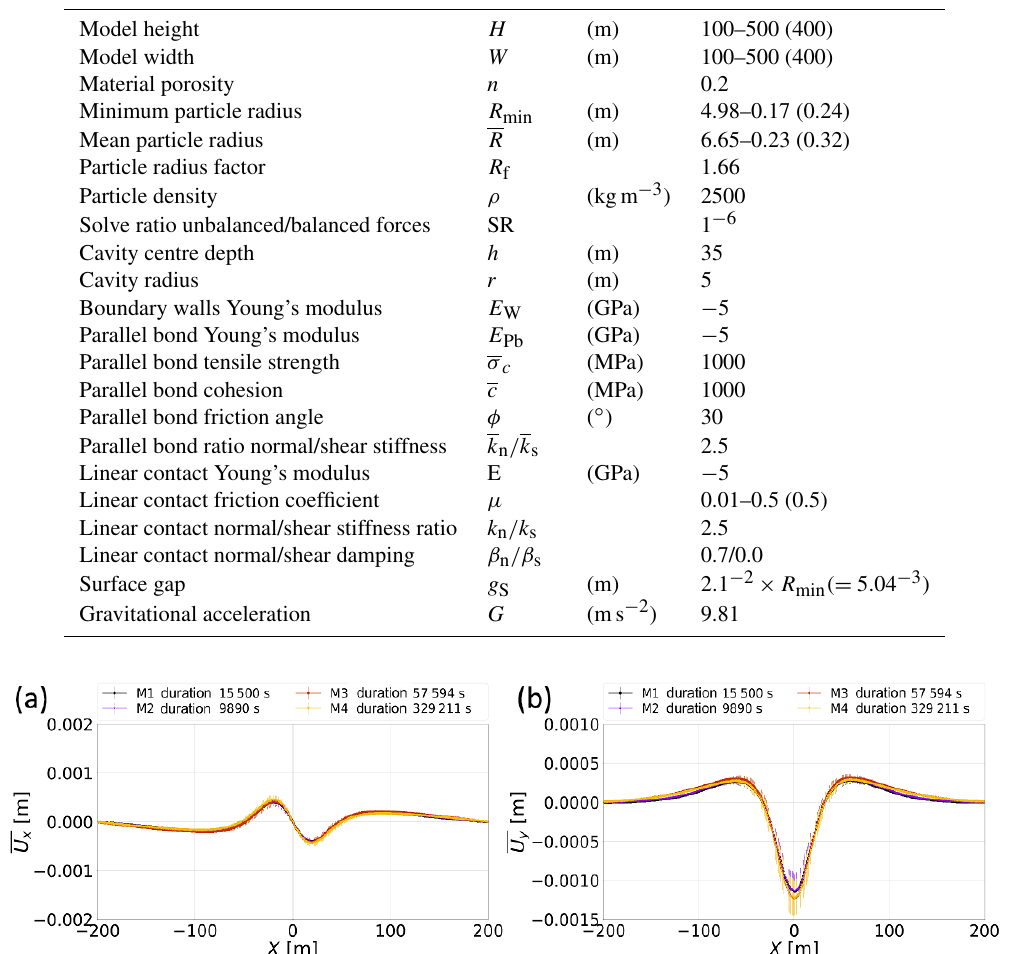
Table B1. Dimensions of the model and contact and particle properties used in development and testing of DEM cavity formation models. Geometric parameter or microparameter